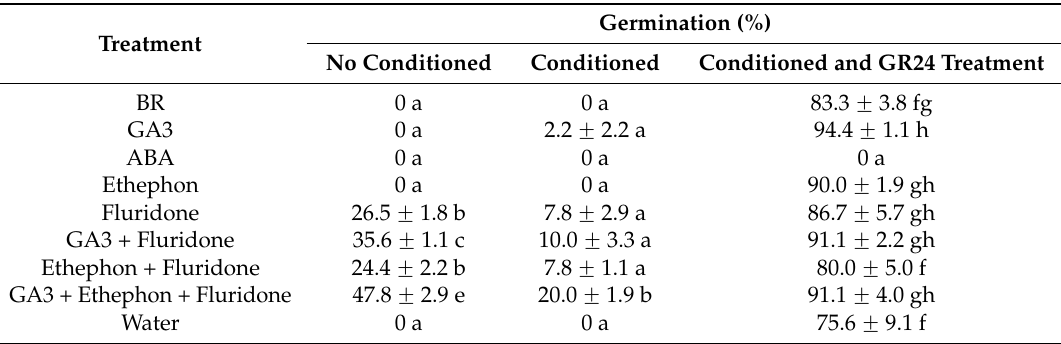
Table 2. P. aegyptiaca seed germination rate under different conditions.